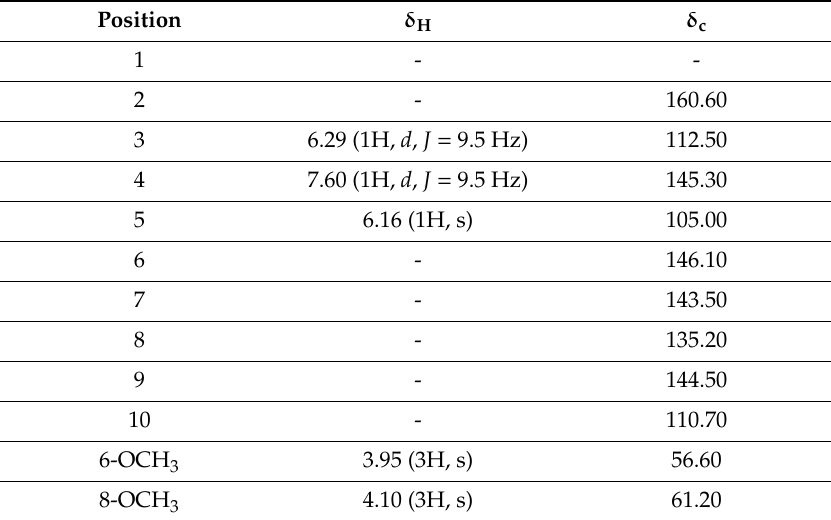
Table 2. The approximate range of ¹H and 13 C NMR chemical shifts ( δ ) of IF.